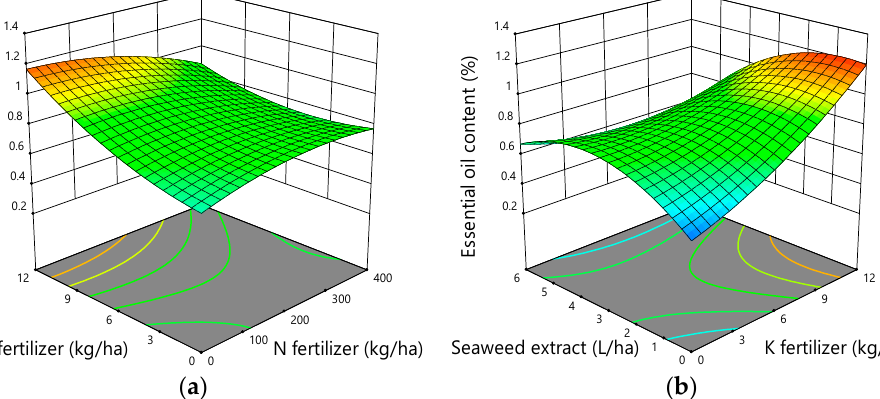
Figure 4. Response surface plots showing the interactive effects of N and K fertilizers ( a ), and K fertilizer and seaweed extract ( b ) on the essential oil content of thyme. Seaweed extract in ( a ), and N fertilizer in ( b ) was kept constant at 3 L ha − 1 and 200 kg ha − 1 ,